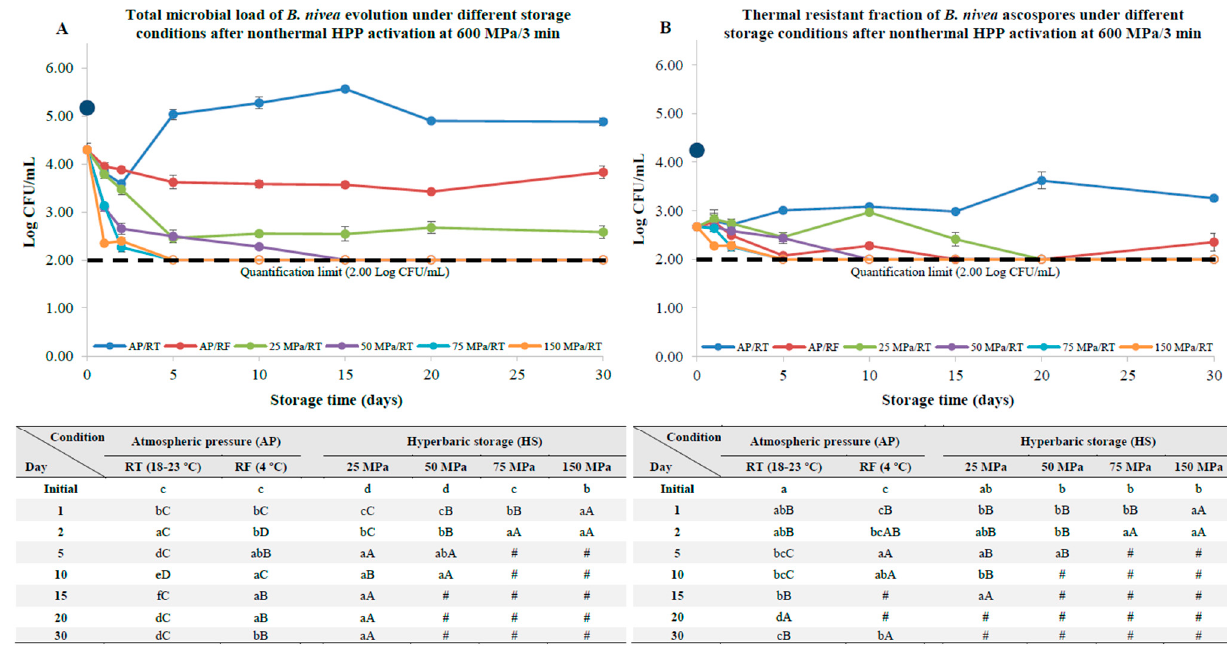
Figure 6. Total microbial load (unheated samples, ( A )) and thermal resistant ascospore fraction (heat-treated samples at 70 °C for 10 min, ( B )) of B. nivea in commercial apple juice (pH 3.7) stored at atmospheric pressure (AP) and naturally variable/uncontrolled room temperature (18–23 °C, AP/RT), AP and refrigeration (4 °C, AP/RF) and hyperbaric storage (25, 50, 75 and 150 MPa, HS) at naturally variable/uncontrolled RT, with a nonthermal activation-step at 600 MPa for 3 min at 17 °C. Statistical analysis available as supplementary material. Different lower-case letters (a–e) indicate significant differences ( p < 0.05) between storage days, while different upper-case letters (A–C) indicate significant differences between storage conditions (for a given day). Cases marked with “#” mean that the quantification limit (of 2.00 Log CFU/mL) was reached, and cases marked with “*” mean that the detection limit (1.00 Log CFU/mL) was reached. The dark blue and larger circle at the Y axis represents the initial load before the nonthermal HPP activation step at 600 MPa/3 min. The dashed line means that the quantification limit was reached.